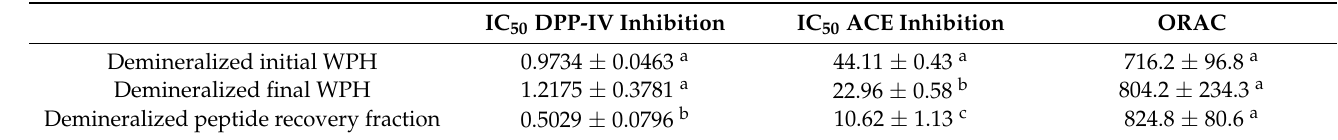
DPP-IV: dipeptidyl-peptidase, IC 50 : half-maximal inhibitory concentration, ACE: angiotensin-converting enzyme, ORAC: oxygen radical absorbance capacity, TE: Trolox equivalent, WPH: whey protein hydrolysate. Column-wise: values with different letters are significantly different, p < 0.05 (Tukey